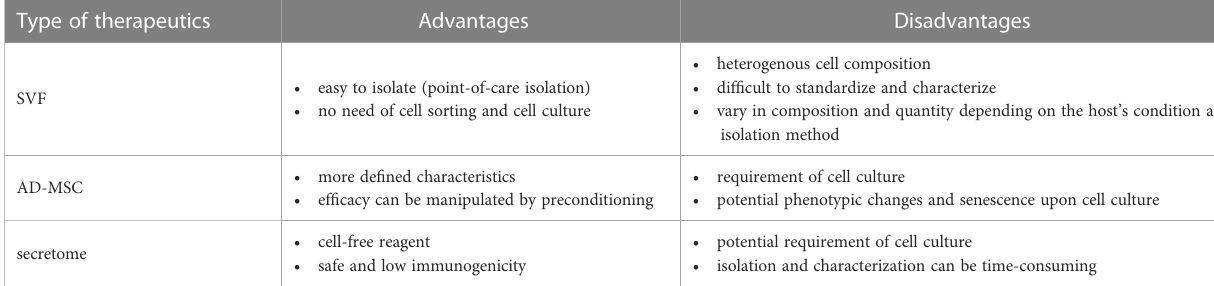
TABLE 2 Summary of adipose-derived therapeutics. Type of therapeutics